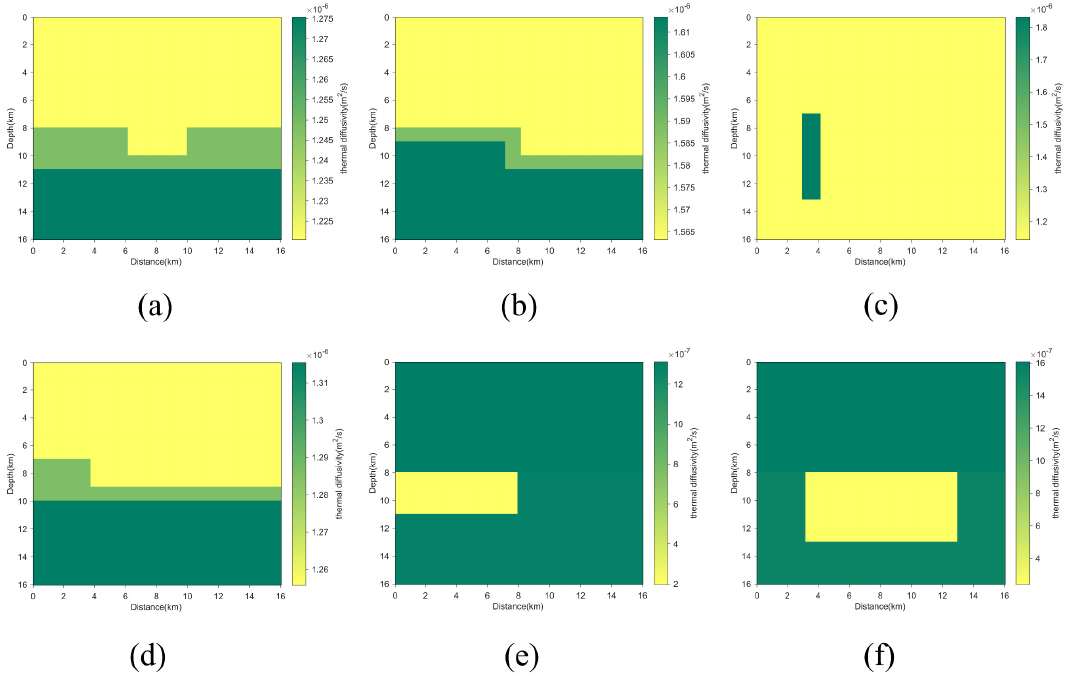
Figure 6. The calculated thermal diffusivity of six geological models ( a – f ): ( a ) Graben model, ( b ) pleated–structure model, ( c ) magmatic intrusion model, ( d ) platform model, ( e ) magmatic intrusion model, ( f ) magmatic intrusion model.